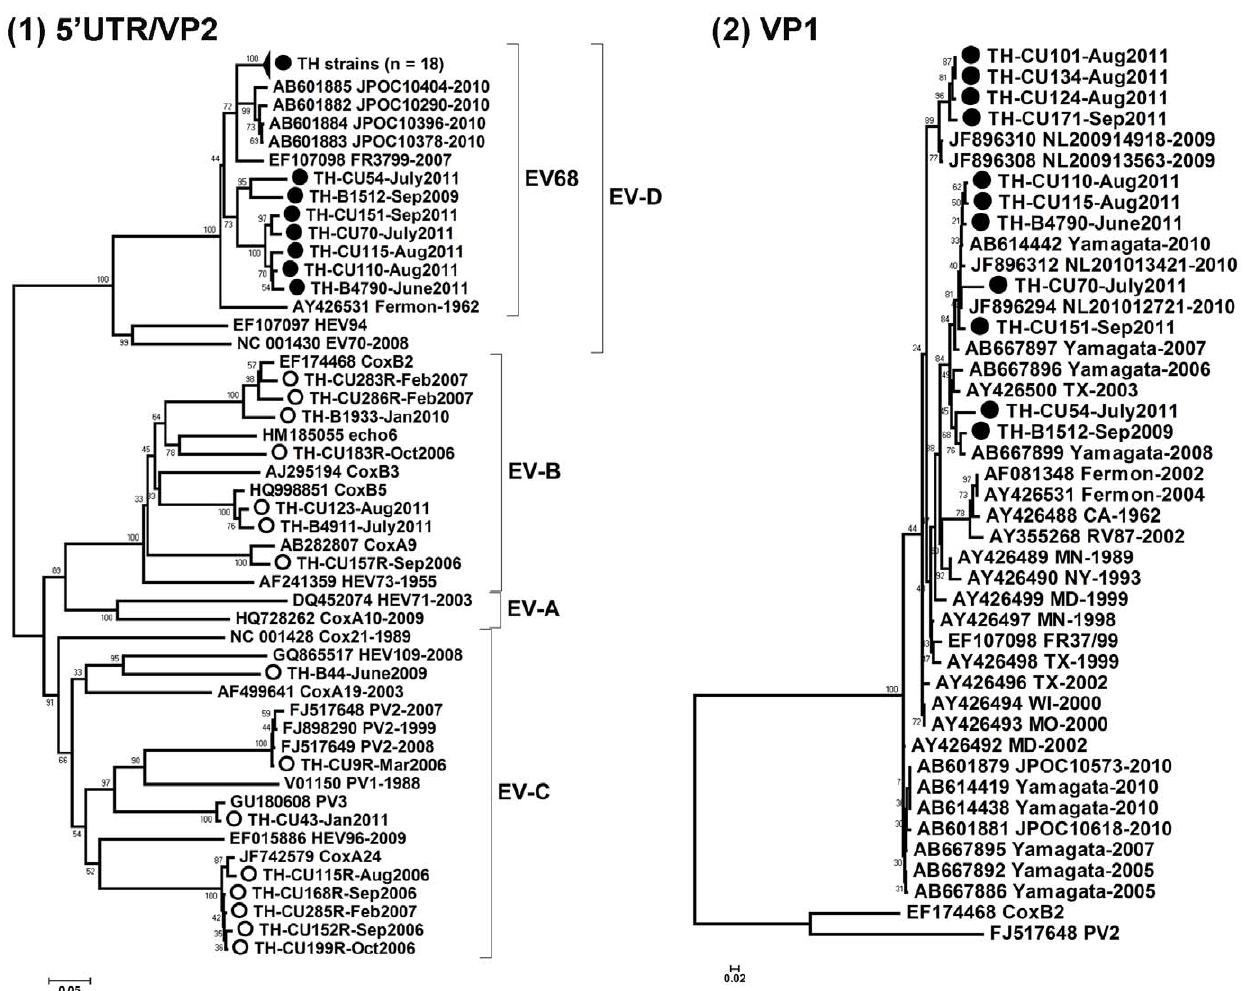
Figure 1. Neighbor-joining (NJ) estimate of phylogenetic relationship for human enteroviruses detected among Thai pediatric children during 2006–2011. The NJ trees were constructed from nucleotide alignments of (A) the 5 9 UTR/VP2 (612 nt) and (B) partial VP1 region (257 nt) using MEGA software. The genetic distances were calculated according to the Kimura-parameter model. Bootstrap support values with 1000 pseudo-replicates were plotted at the internal branch nodes. EV species A to D were labeled. Period of the sample collection was plotted for each lineage. EV68 and other EVs identified in this study (TH-strain) are indicated in black and white circles, respectively. Virus sequence names or location of isolations shown with GenBank accession numbers were reference strains. Scale bar indicates number of nucleotide substitutions per